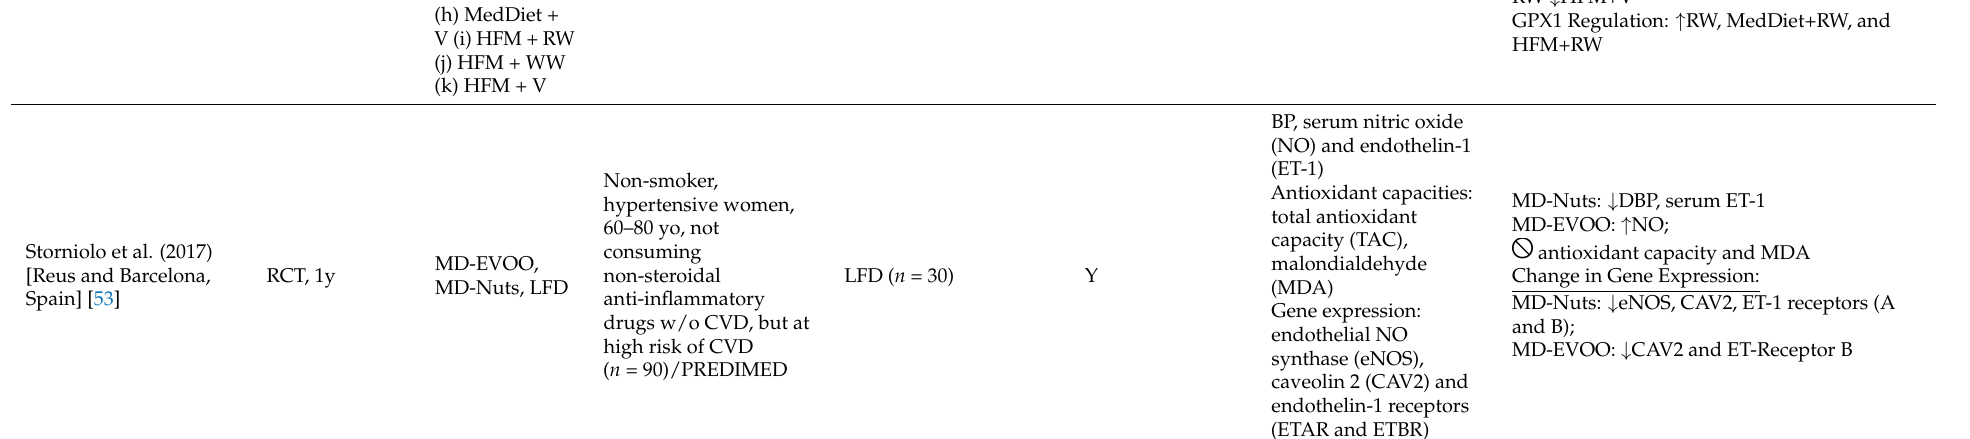
Table 2. Clinical